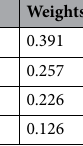
Relevance Measurability Data availability Comparative Overall weights Rounded